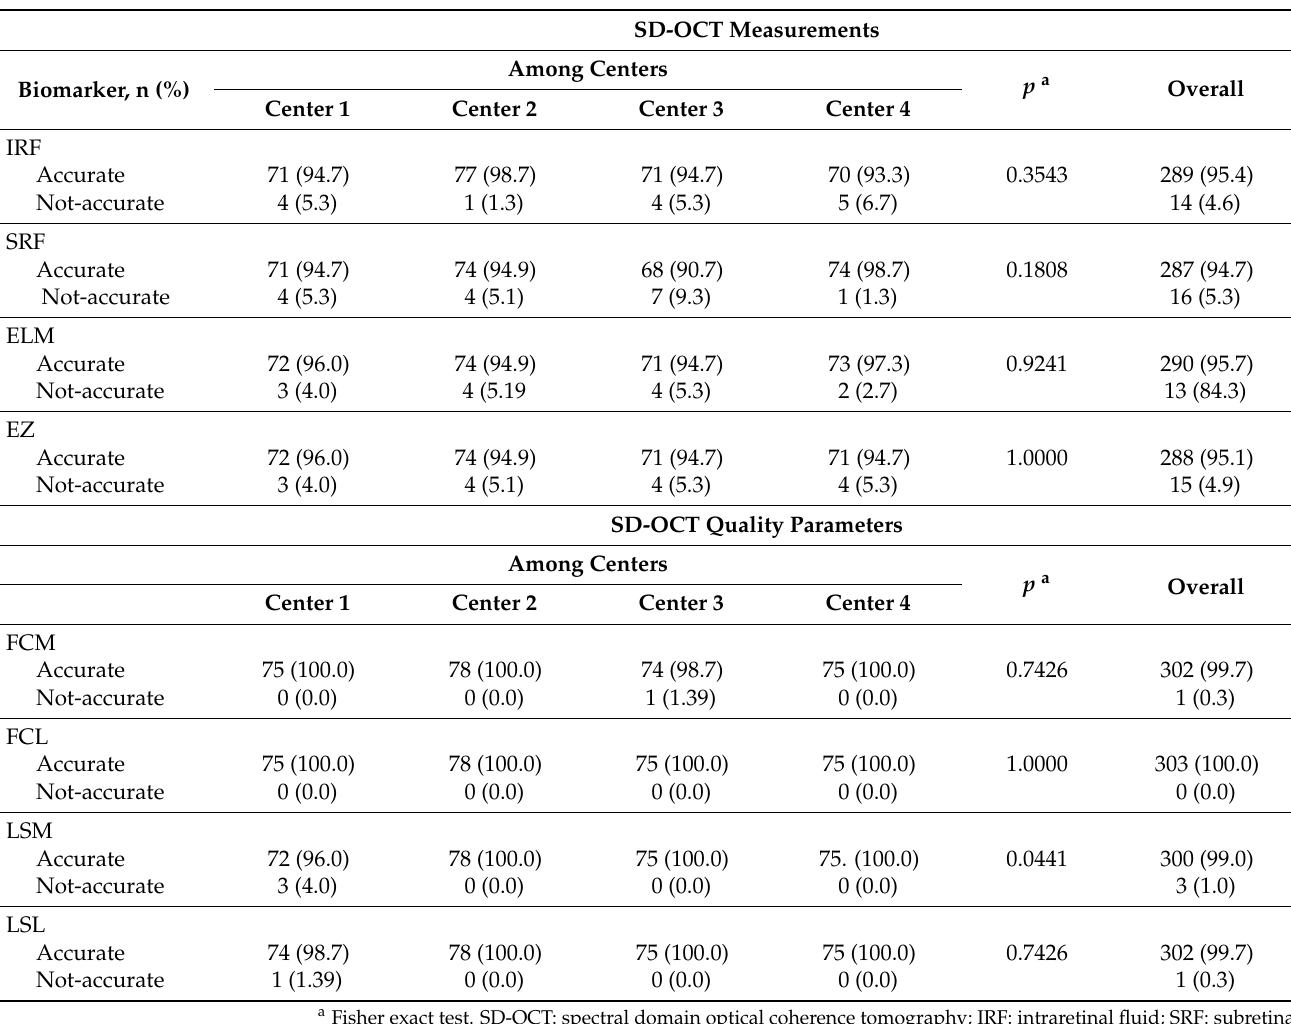
Table 4. Biomarker quantification accuracy and quality parameters in the overall study sample and among the different study